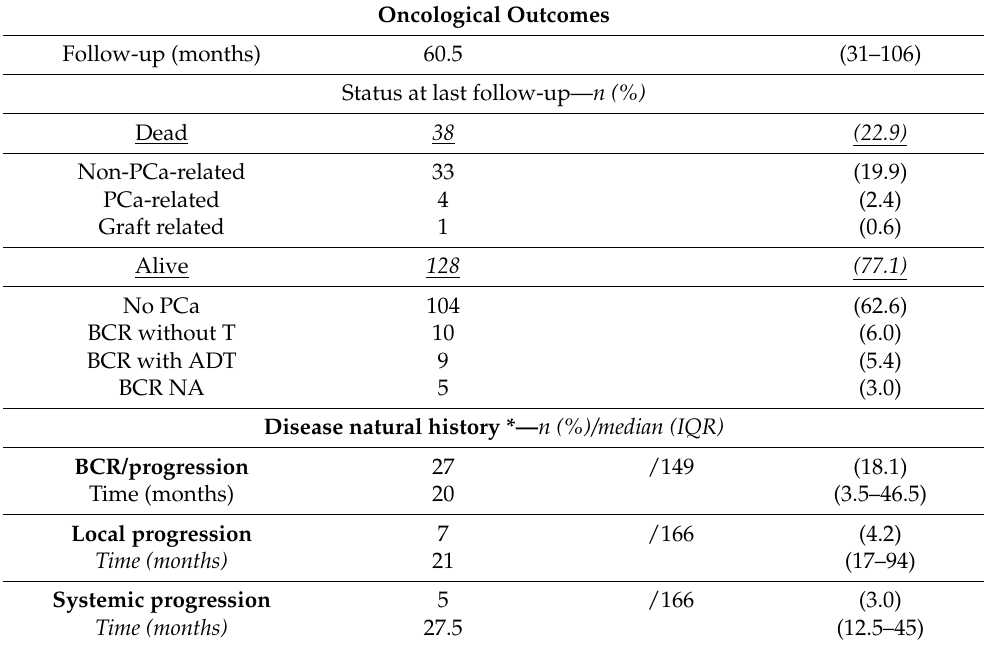
Table 3. Oncological outcomes of kidney transplant patients being diagnosed with cM0 prostate